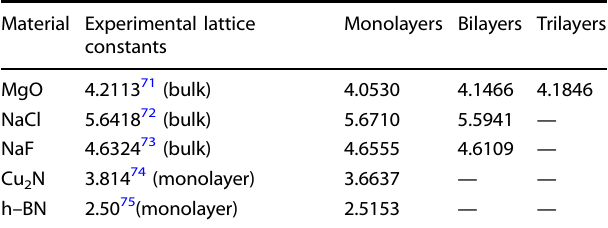
Table 1. Experimental vs. theoretical lattice constants for the considered